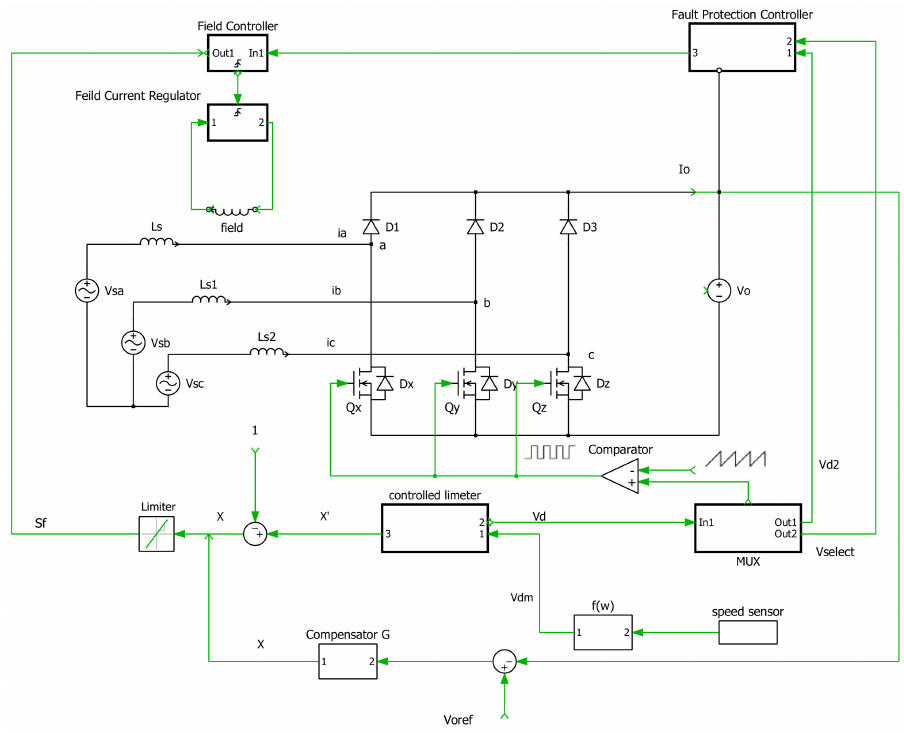
Figure 37. Controllers for the proposed system “Reprinted from [42]”.